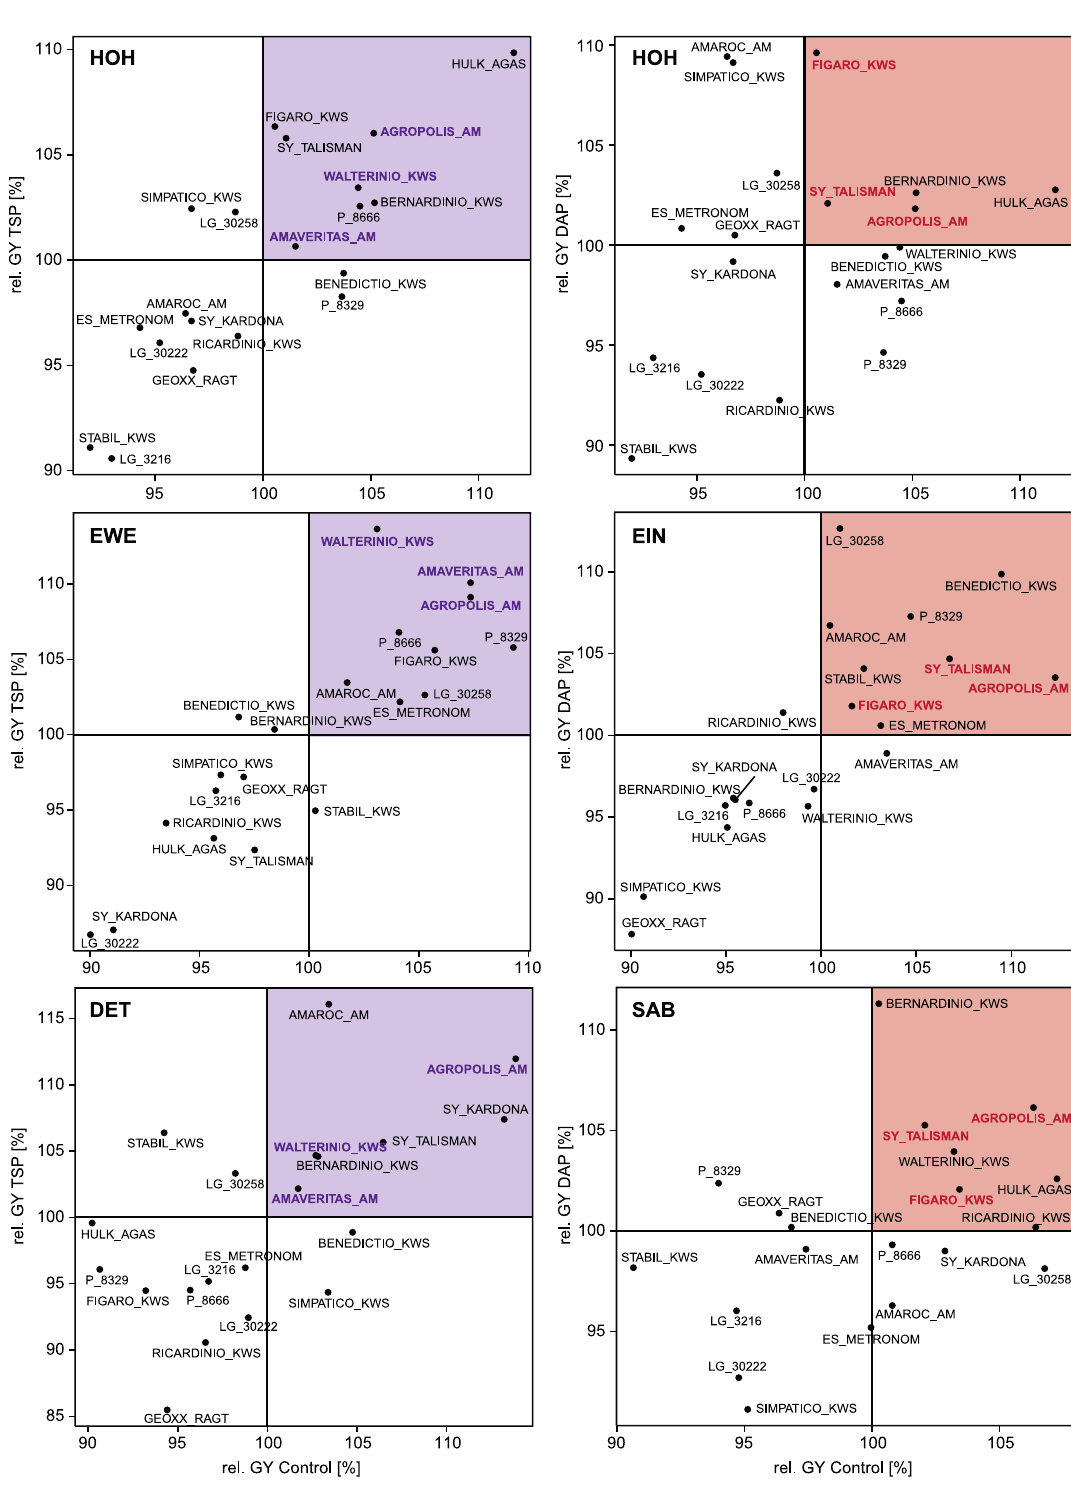
PLOS ONE | https://doi.org/10.1371/journal.pone.0250496 April 22,